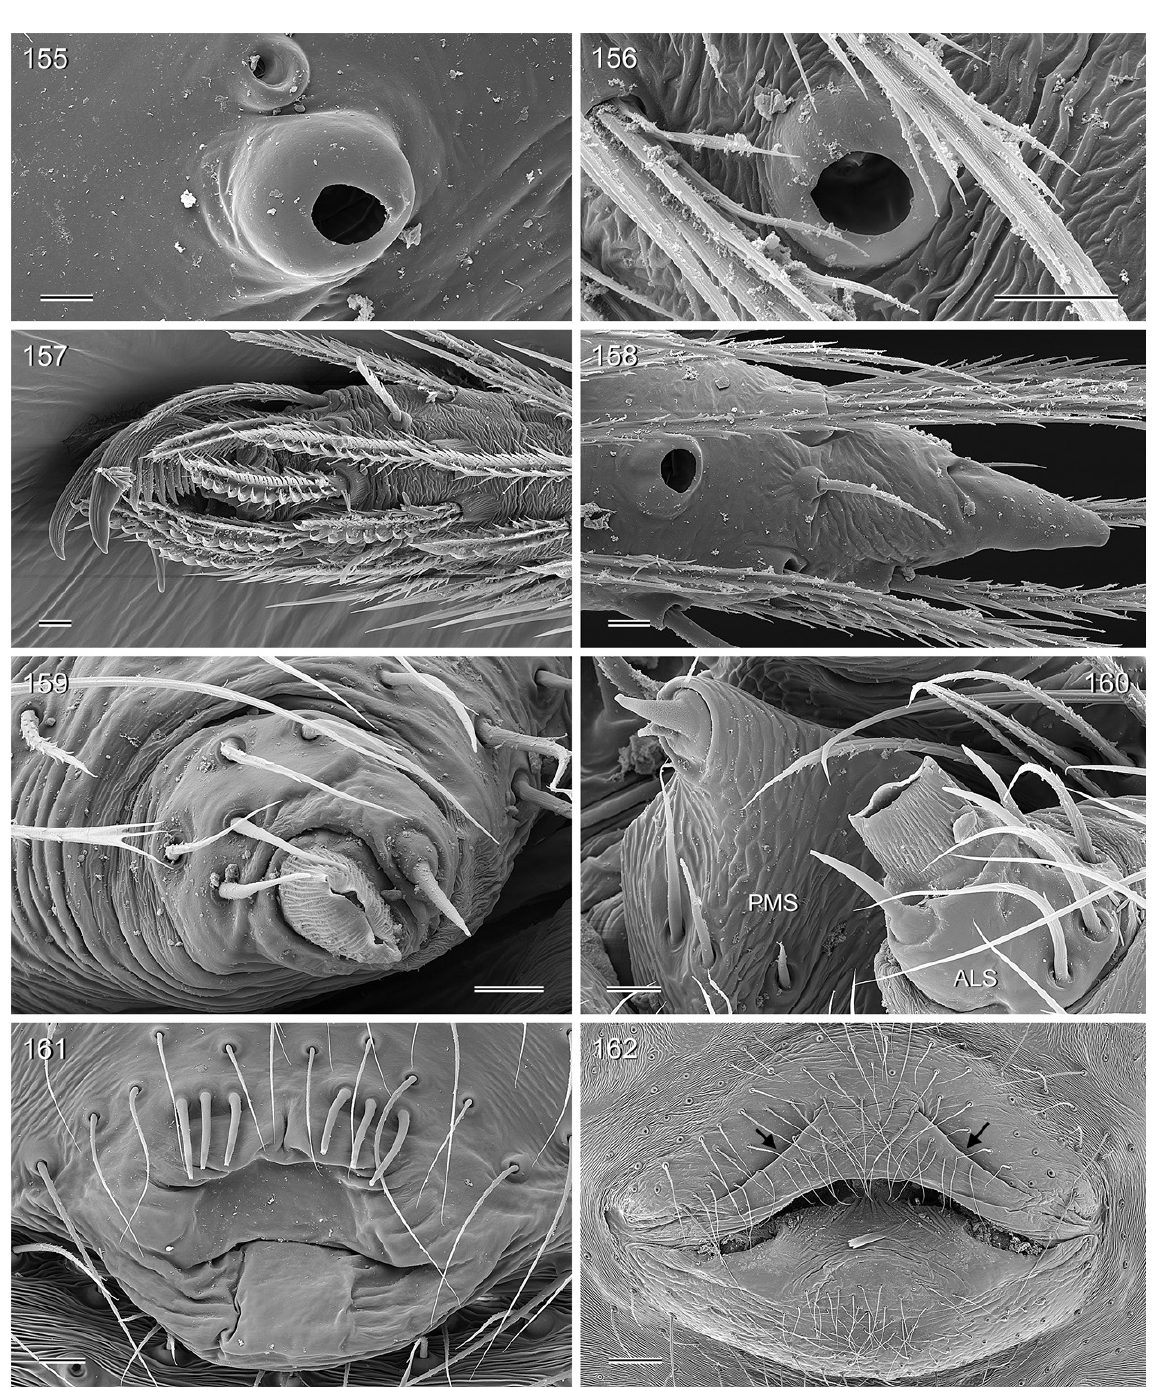
Figs 155–162. Holocnemus hispanicus Wiehle, 1933; male and female from Spain, Huelva, “Alájar/ Aracena” (MHNG). 155 . Male palpal tarsal organ. 156 . Tarsal organ on male tarsus 3. 157 . Tip of male right tarsus 4, showing comb-hairs. 158 . Tip of female palp with tarsal organ. 159 . Male ALS. 160 . Female spinnerets. 161 . Male gonopore. 162 . Epigynum; arrows: pockets. Scale bars: 155–160 = 10 µm; 161 = 20 µm; 162= 100